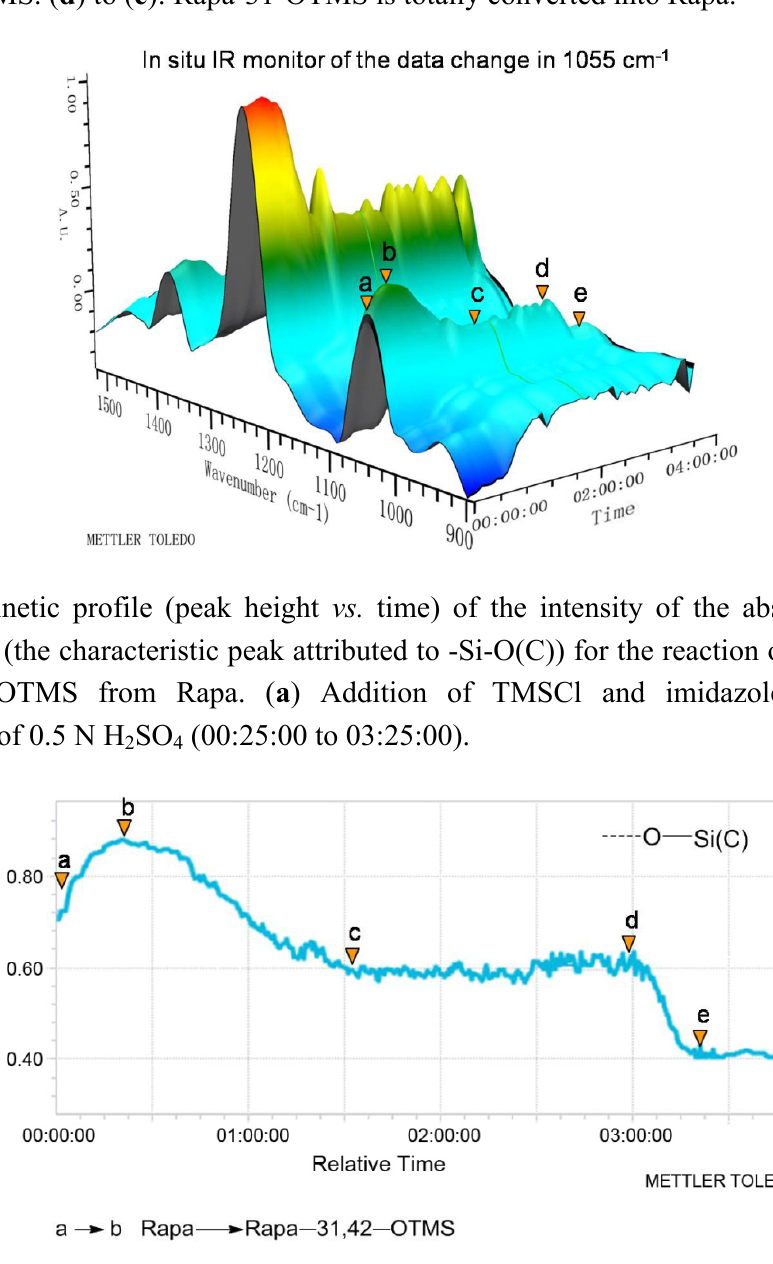
Figure 3. 3D FT-IR spectrum fragments for the preparation of Rapa-31-OTMS from Rapa. The reaction was monitored from 0 to 230 min. ( a ) Addition of TMSCl and imidazole (00:05:00). ( b ) Addition of 0.5 N H SO (00:25:00 to 03:25:00). ( a ) to ( b ) Rapa is totally 2 4 converted to Rapa-31,42-OTMS. ( b ) to ( c ) Rapa-31,42-OTMS is mostly converted into